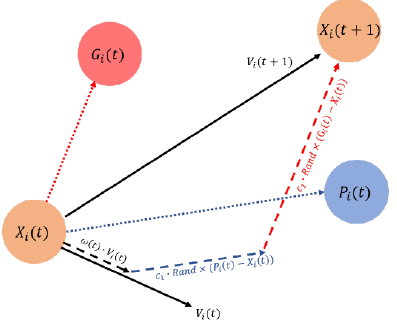
Figure 11. Schematic diagram of a mathematical model of PSO .